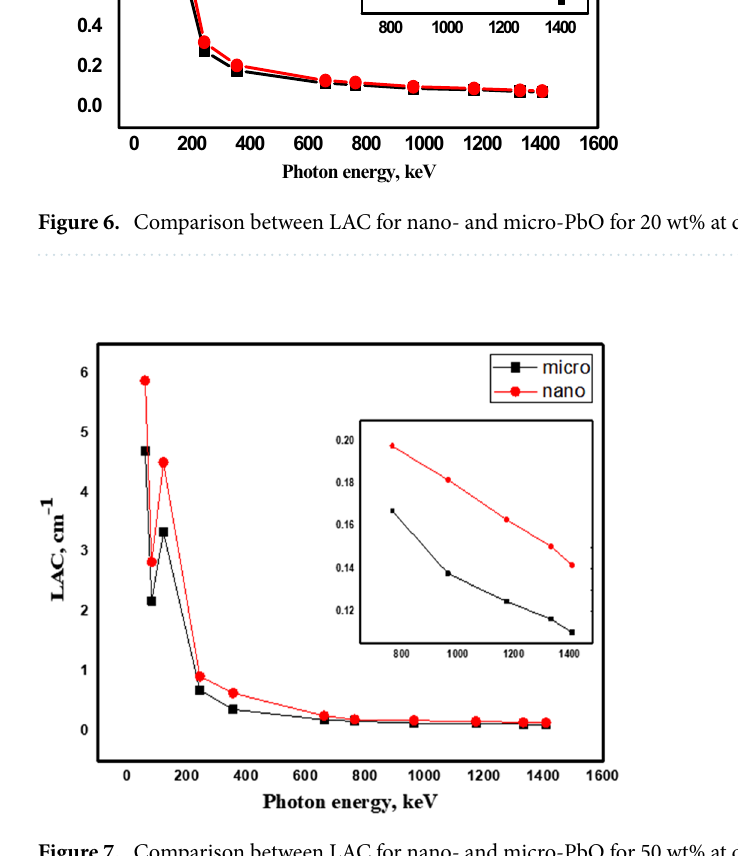
Figure 7. Comparison between LAC for nano- and micro-PbO for 50 wt% at different energy